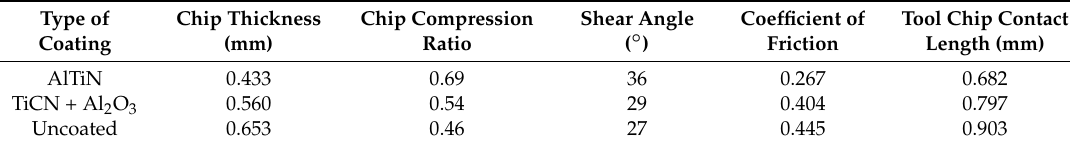
Table 3. Cutting characteristics during the turning operation of SDSS. Results were calculated according to standard procedures [19].